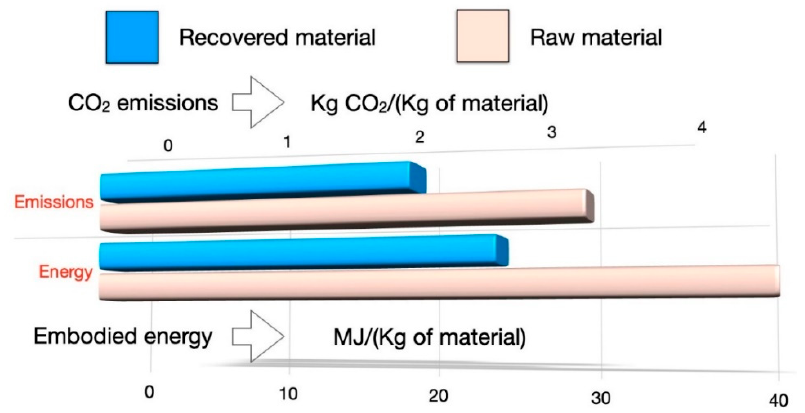
Figure 1. The basis of ESCAPE method, i.e., the embodied energy (EE) and the carbon footprint (CF) of recovered materials evaluated in comparison to the corresponding values for a natural resource (raw material). The method compares energies and emissions involved in the treatment of a by-product and corresponding values necessary for the synthesis of the raw material, to evaluate the sustainability. The most sustainable materials have the lowest EE and CF values. In this example the recovered material shows lower CO 2 emissions and EE in comparison to the corresponding raw material.